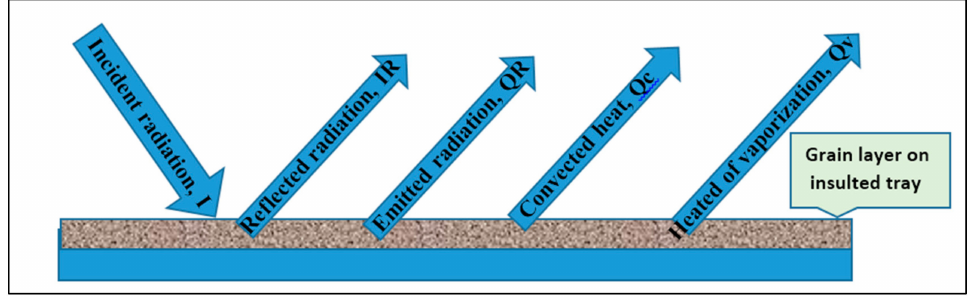
Figure 5. Energy balance on a thin layer of rough rice exposed to IR